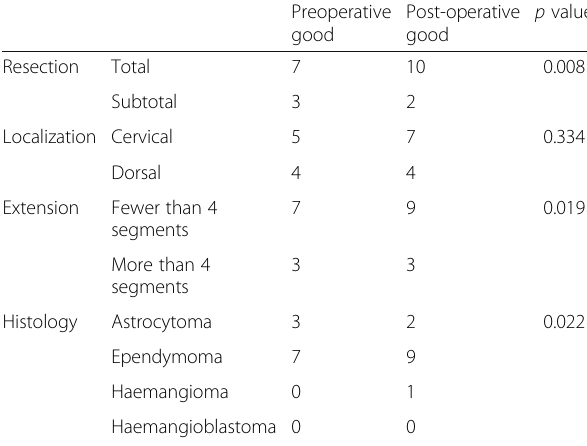
Table 3 Surgical outcome according to different variables